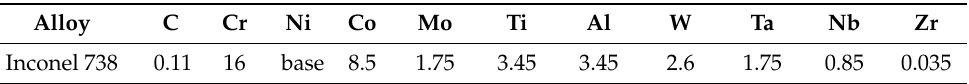
Table 1. Chemical composition of virgin and revert IN738 by producer [wt.%].